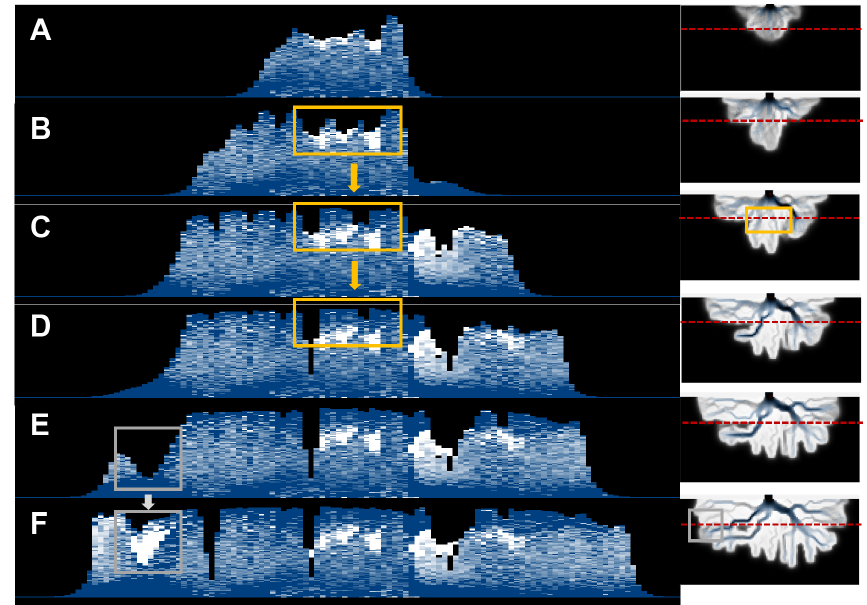
Figure 12. Time series of the stratigraphic slice in the strike direction about 20 cells (1km) away from the inlet channel. Note that be- tween (b) , (c) and (d) , in the yellow box, the abandoned channel belts are covered by muddy floodplain deposits. Also note that between (e) and (f) , in the light gray box, a mouth bar quickly deposits a significant amount of